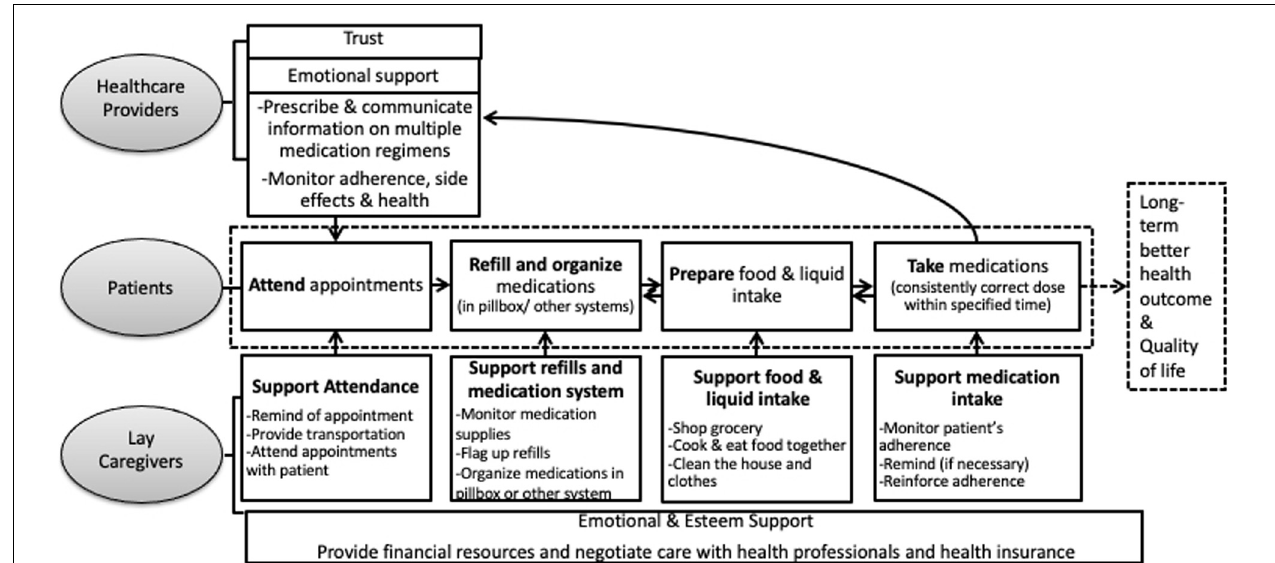
FIGURE 2 | Cascade of social support tasks to ensure adequate